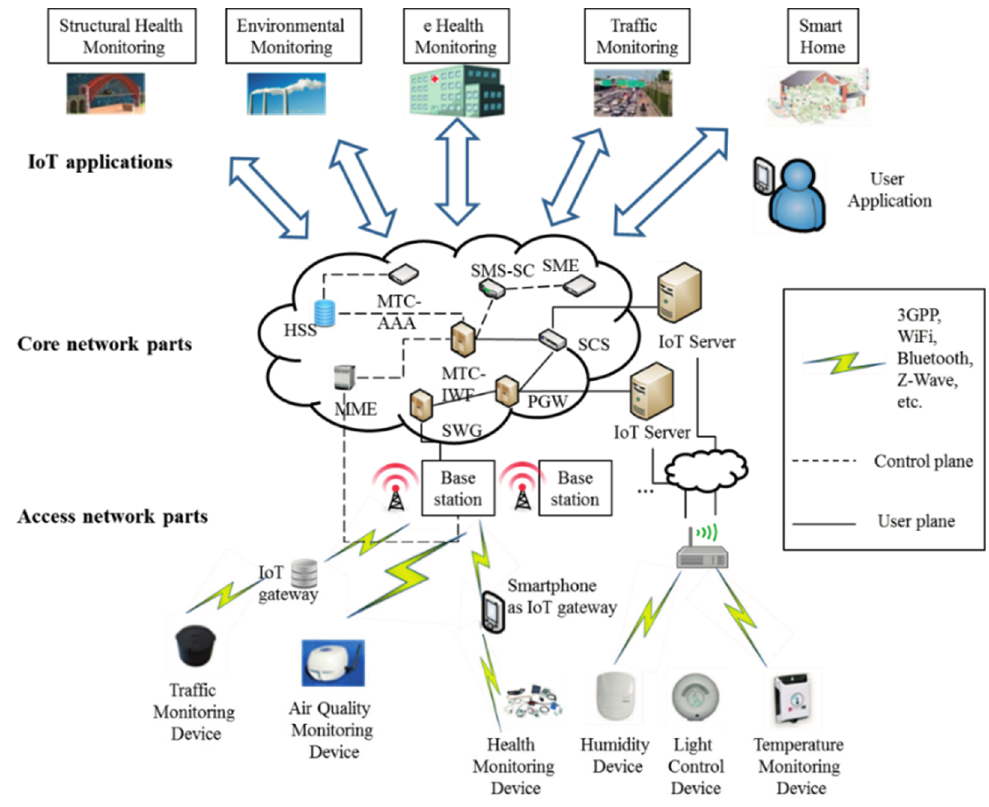
Figure 1. A generic Internet of Things (IoT) network architecture.